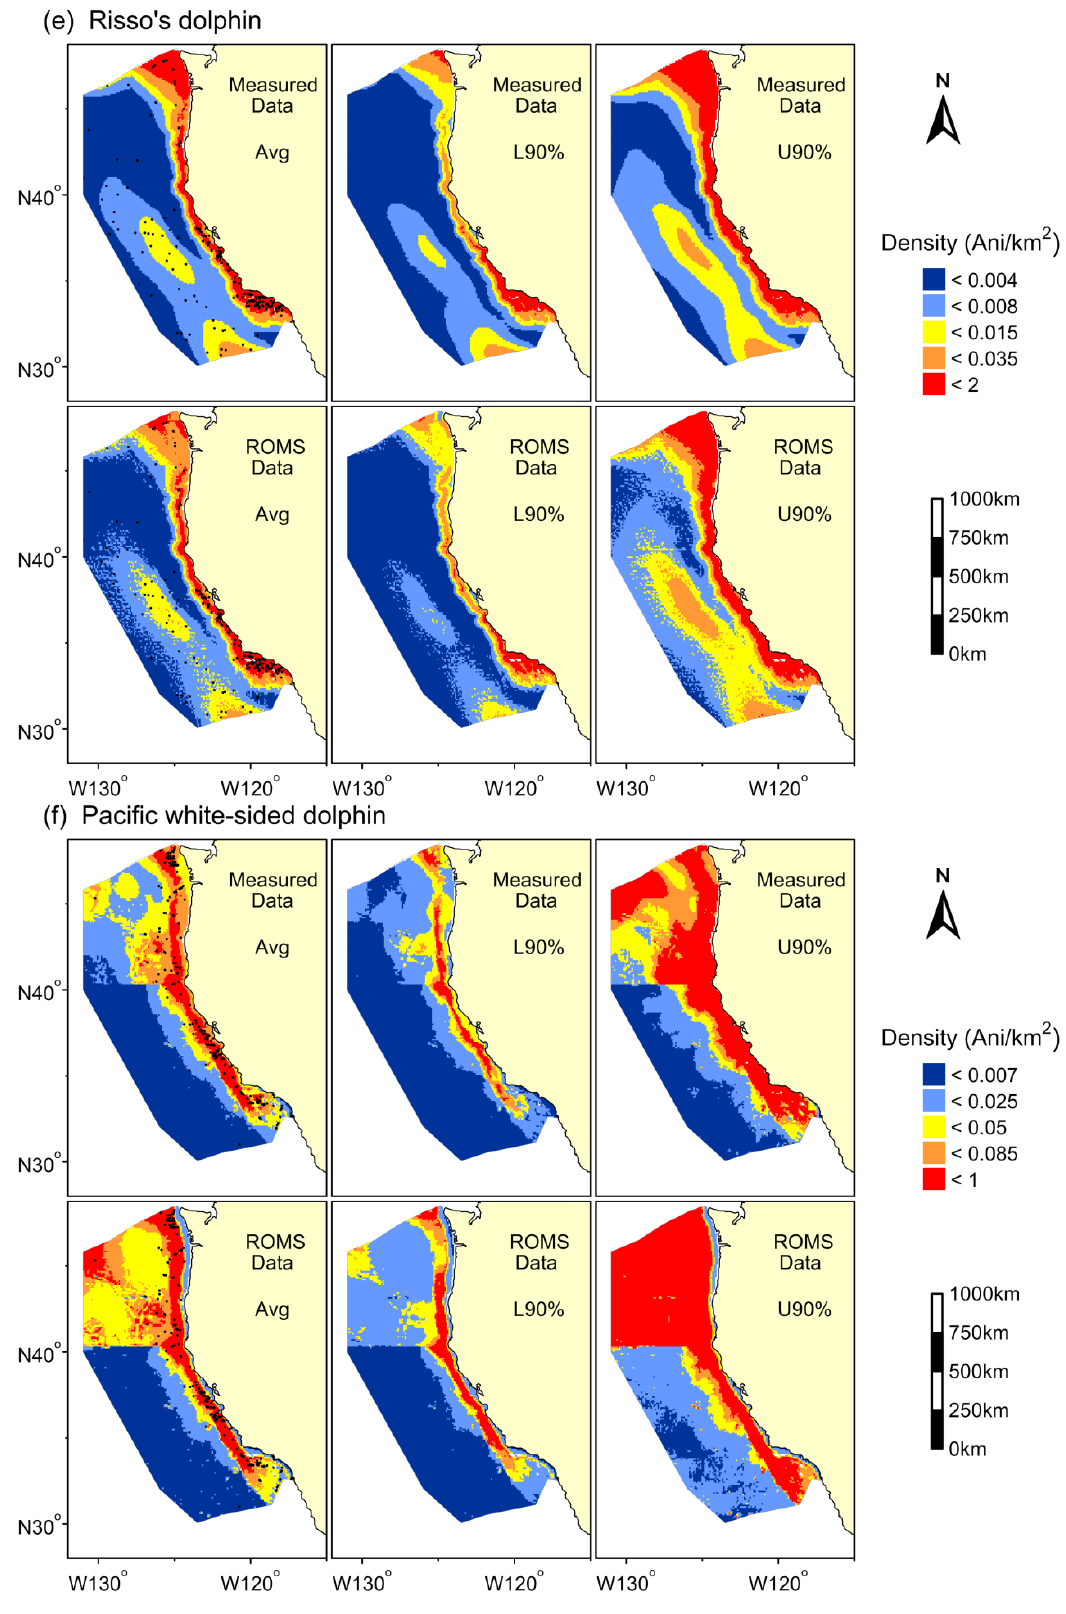
Figure 2. Cont. Figure 2.